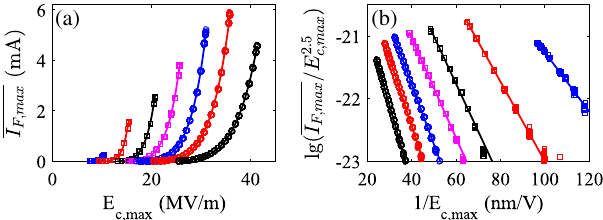
FIG. 13. The dependence of I F; on E c; during rf con- max max − I ditioning, plotted in the E c; F; max coordinate (a) and the F-N max coordinate (b). The dots denote the experimental data, and the lines represent the linear fitting results from the F-N coordinate. FIG. 15. The current evolution during the 4-h longevity The seven curves, from left to right in (a) and from right to left in measurement. Blue dots: Measurement results; red line: fitting (b), were taken when E c; reached 10, 15, 21, 26, 31, 36, and to I ð t Þ ¼ I 0 exp ð − t= τ l Þ . max 42 MV = m, respectively.